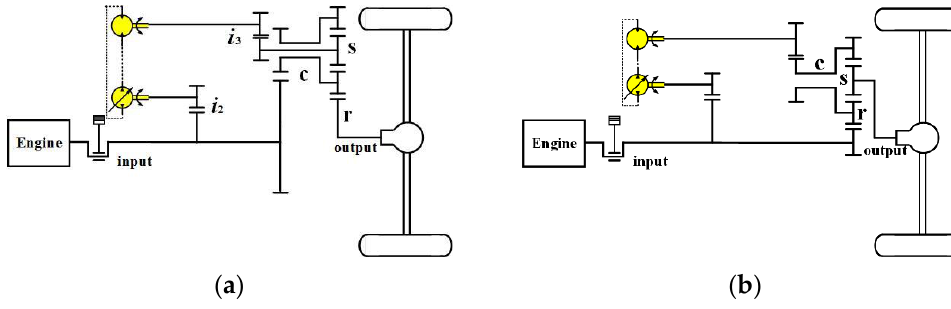
Figure 9. Equivalent transmission principle diagram: ( a ) HM1 (HM3) and ( b ) HM2 (HM4).